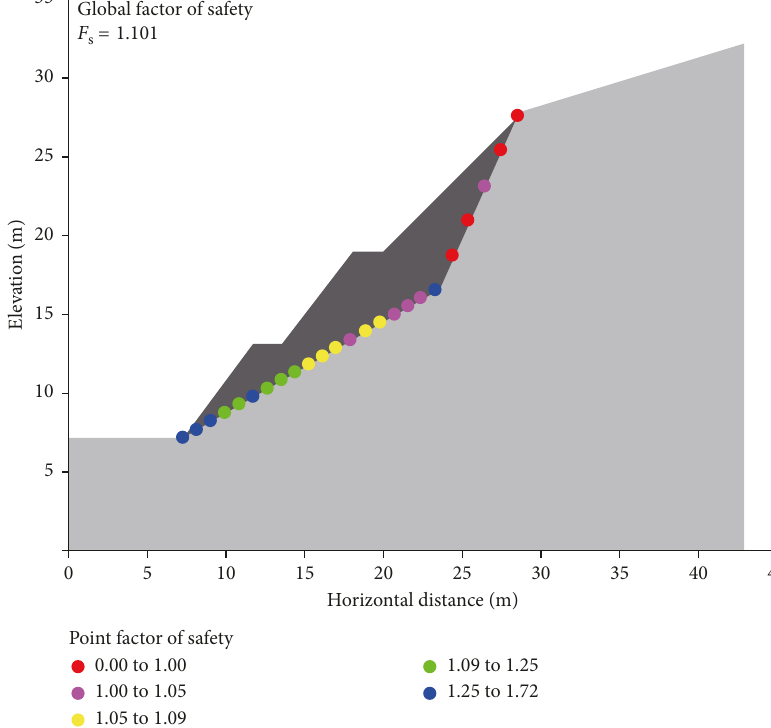
Figure 3: Result obtained by the presented method of the verification